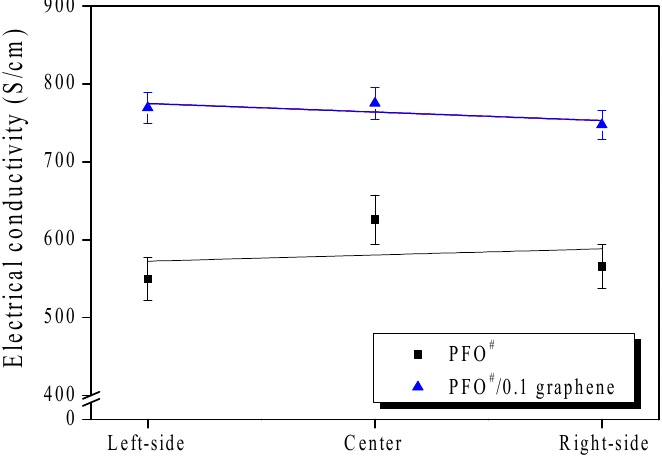
Figure 5. Electrical conductivity of PFO # -based carbon fibers.